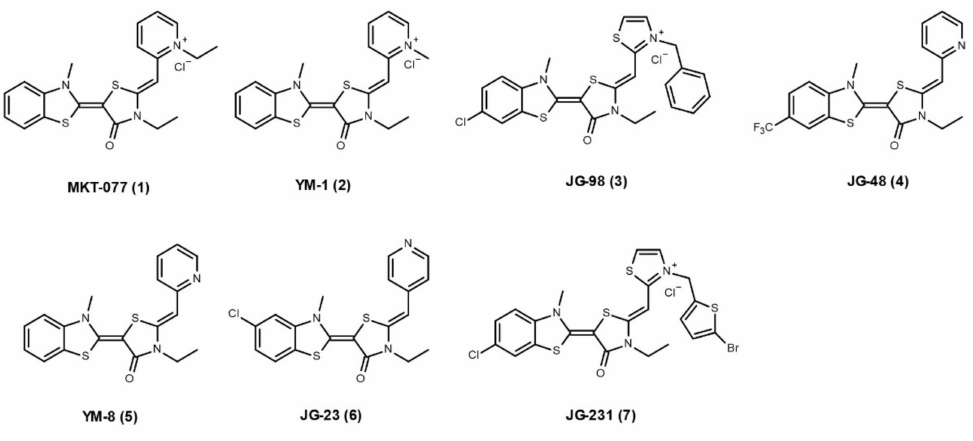
Figure 2. Small molecules with the ability to disrupt Hsp70/co-chaperone